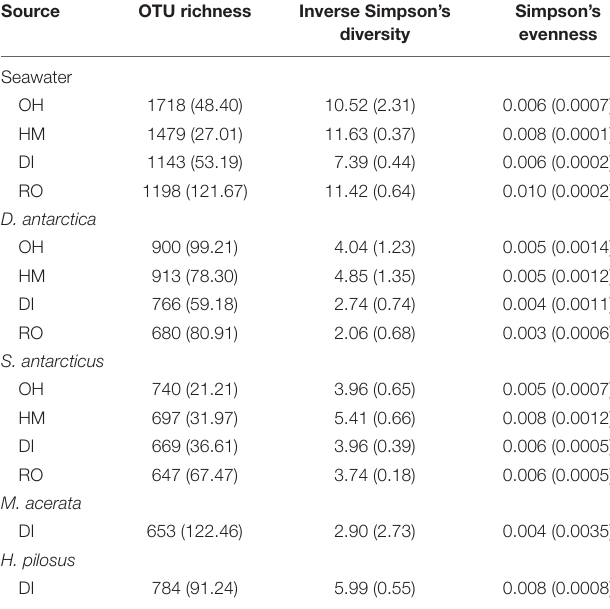
TABLE 2 | Diversity estimators for microbial communities associated with seawater, Dendrilla antarctica , Sphaerotylus antarcticus, Mycale acerata